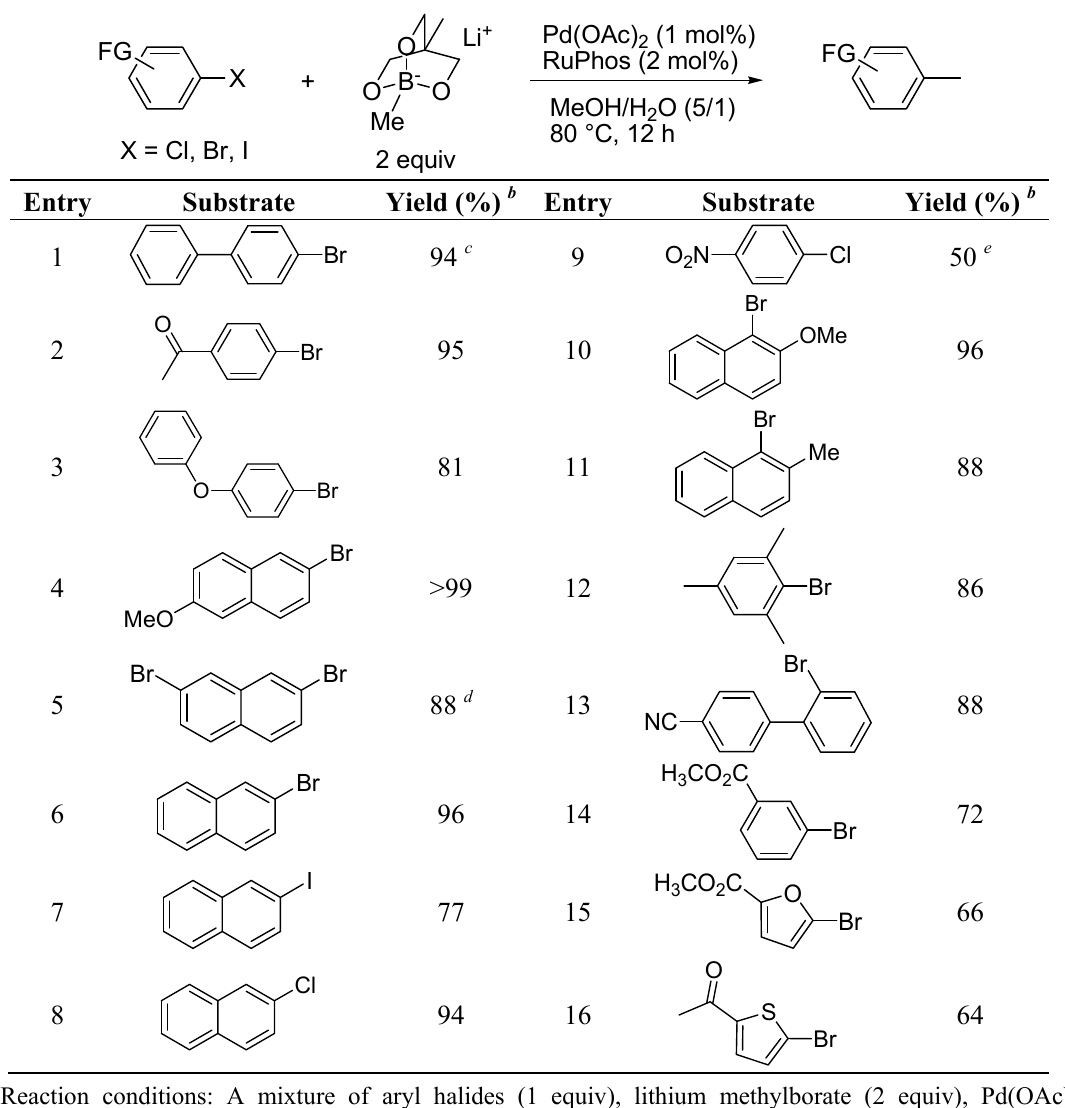
Table 3. Cross-coupling between lithium methyltriolborate and aryl halides a